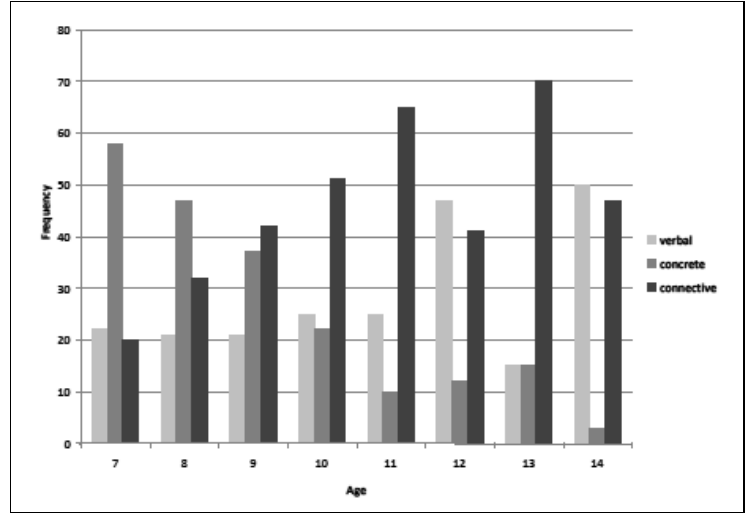
Figure 1 . Percentage, by age, of the most developed types of